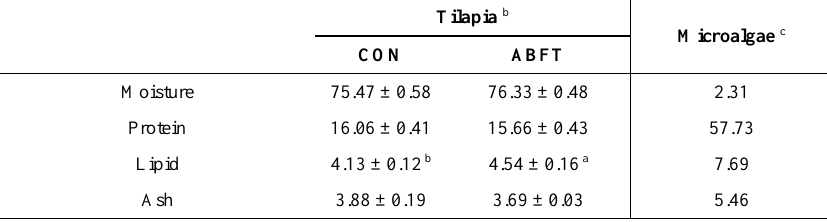
a Values are means from triplicate groups of fish where the values in each row with different superscripts are significantly different ( P < 0.05)